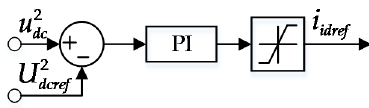
Figure 9. Control structure of the DC voltage controller.